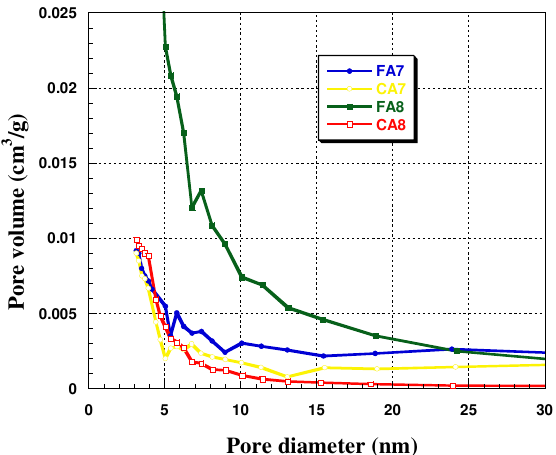
Figure 1. Pore size distribution of samples